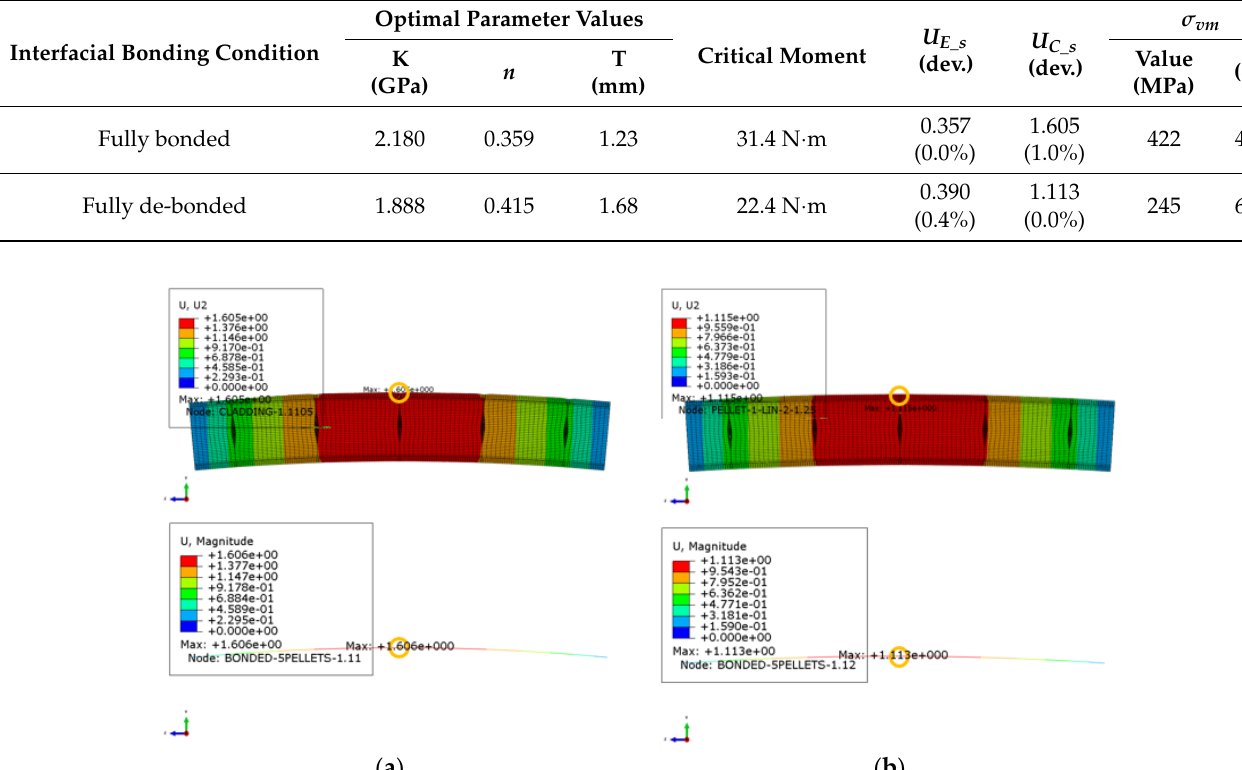
Figure 10. Deform shape for the critical moment of the detailed model and simplified model: ( a ) fully bonded condition; ( b ) fully de-bonded condition.